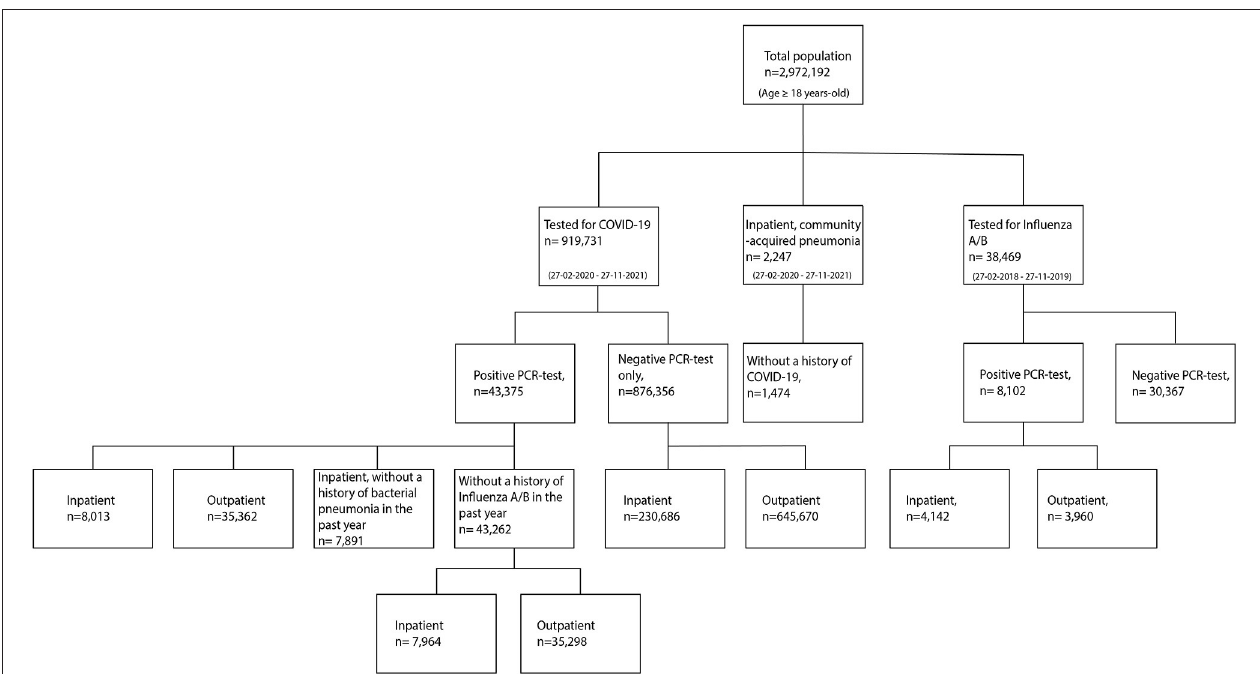
FIGURE 1 | Flowchart of individuals tested for COVID-19 or Influenza A/B, and diagnosed with community-acquired bacterial pneumonia.